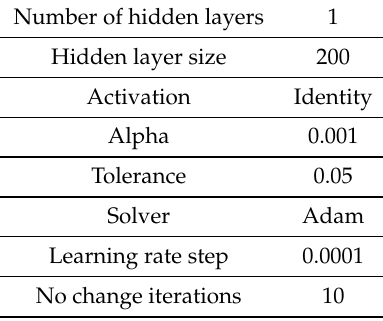
Table 8. Final MLP